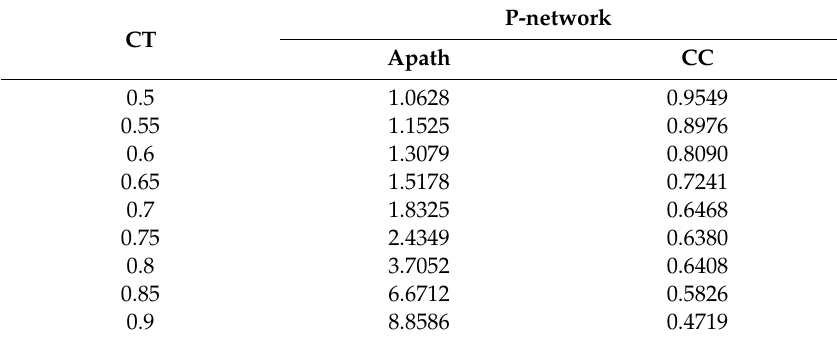
Table 4. The global clustering coe ffi cient and the average path length for the P-network. CT